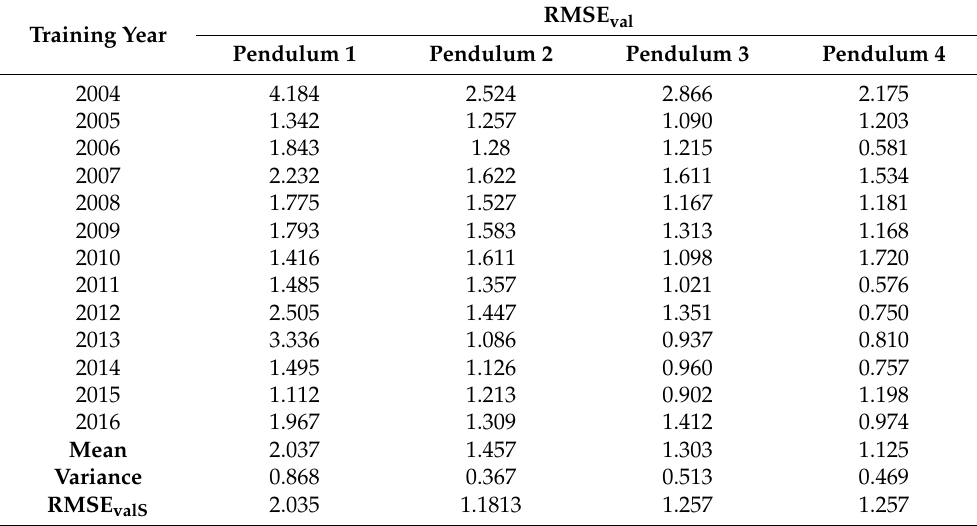
Table 4. Results of Test I, which consists of changing the training Hold-out set of Blending